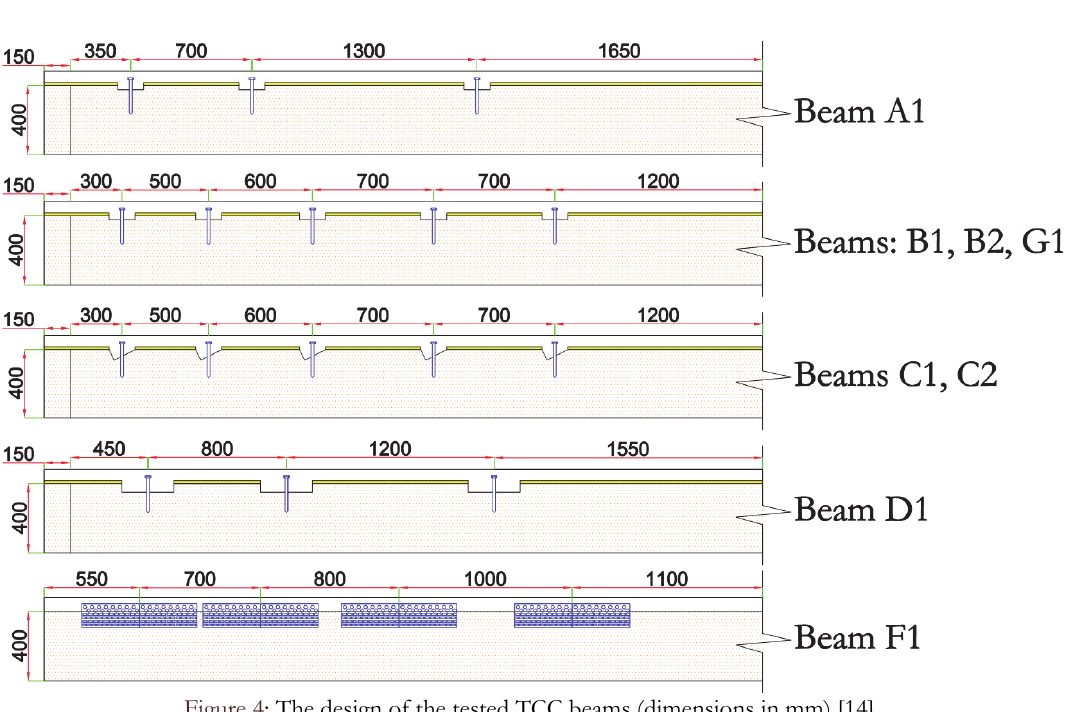
Figure 4: The design of the tested TCC beams (dimensions in mm)